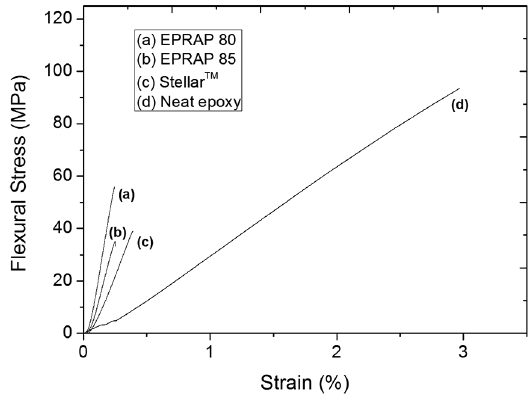
Figure 1. Flexural strength versus deflection strain curves for: EPRAP 85, EPRAP 80, neat epoxy and commercial ornamental stone. Table 1. Density, water absorption, apparent porosity and flexural strength of sintering electrostatic precipitator artificial stone plates (EPRAP), commercial artificial stone, epoxy and electrostatic precipitator residue (EPR).